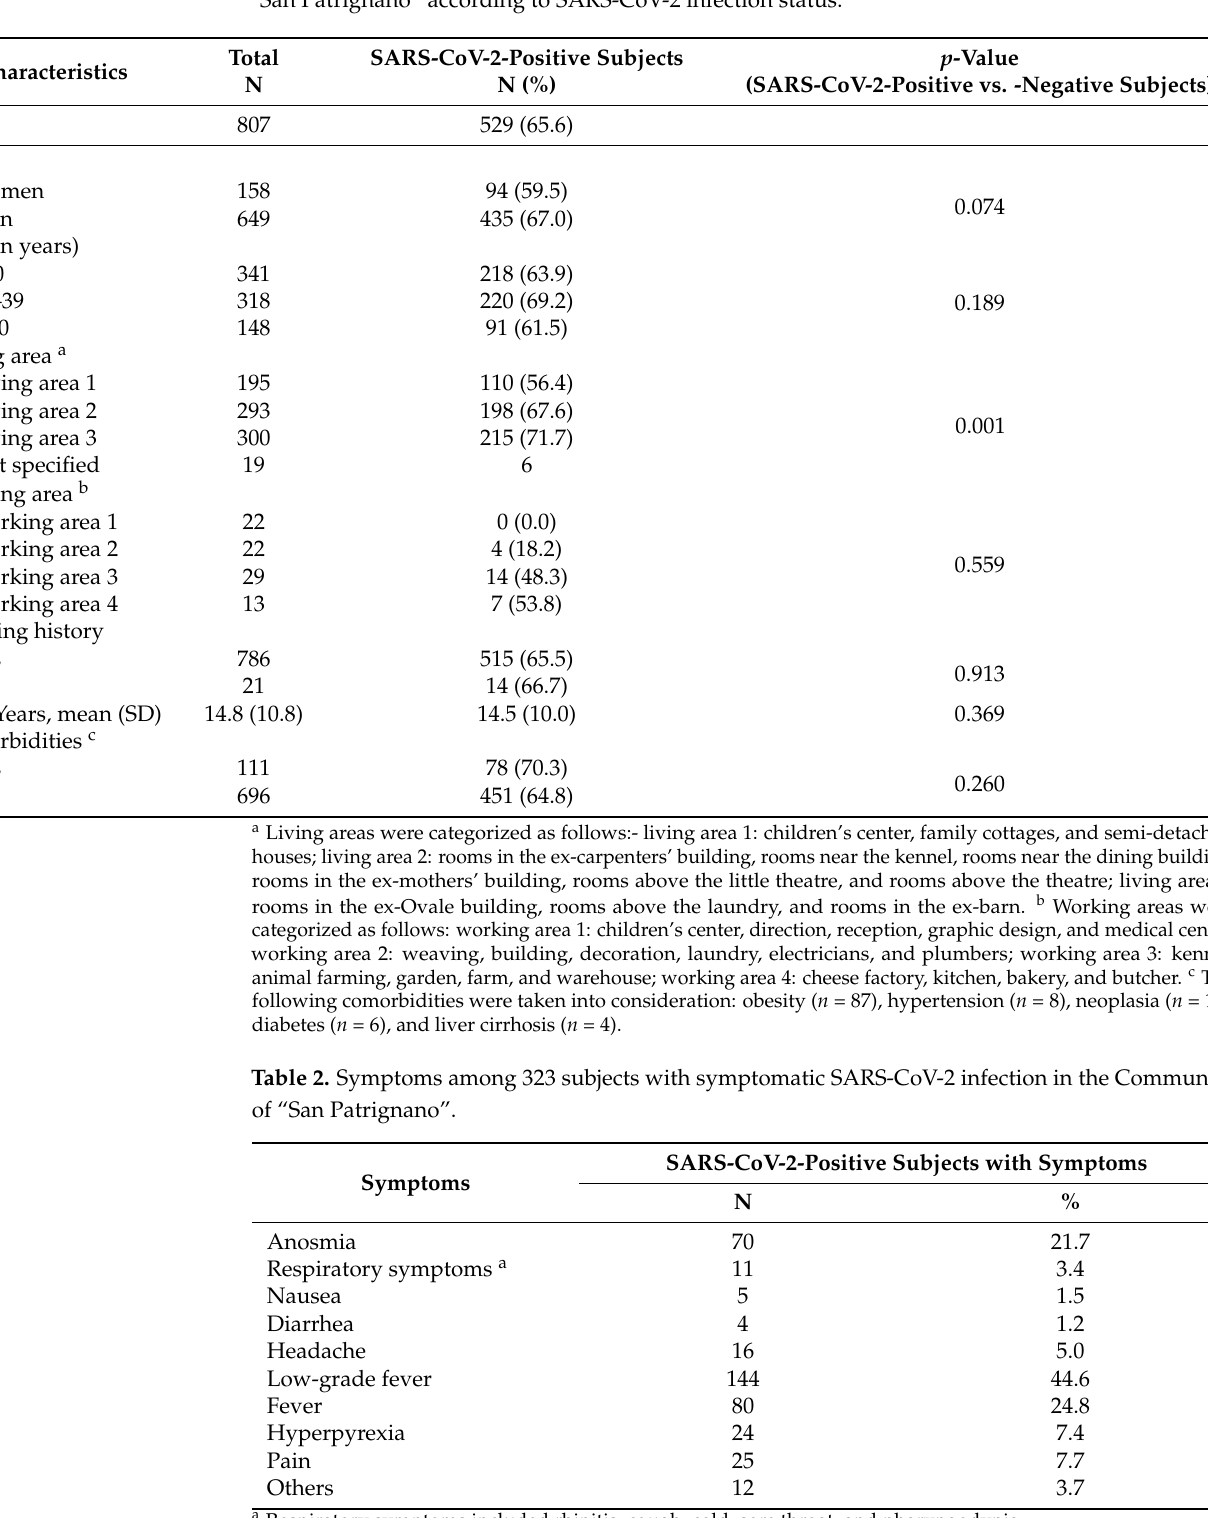
Table 1. Demographic and clinical characteristics of former drug users living in the Community of “San Patrignano” according to SARS-CoV-2 infection status.